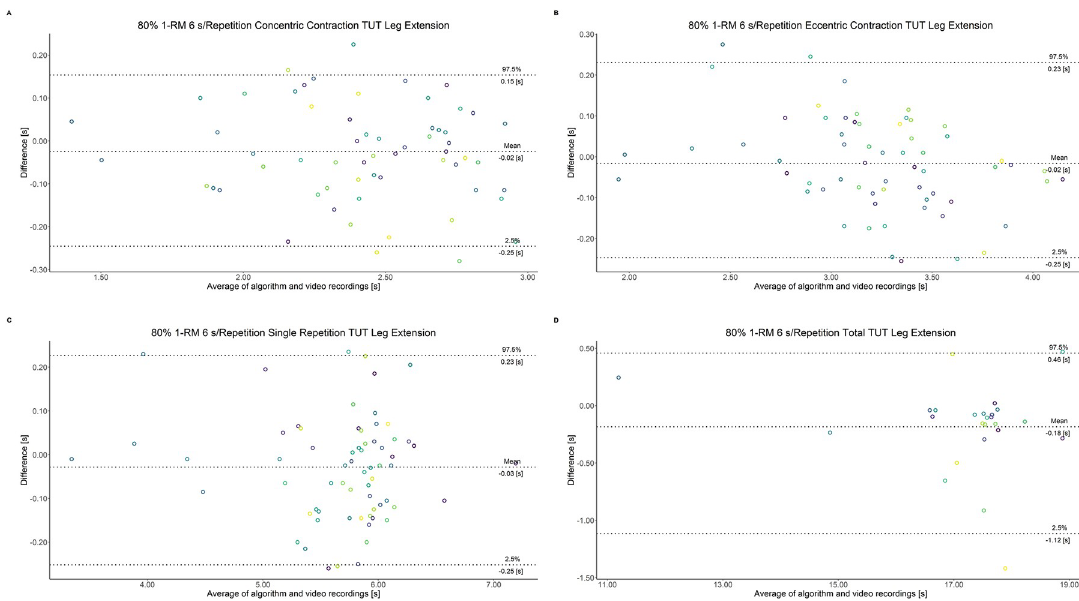
Fig 13. Bland-Altman plots of agreement between algorithmically accelerometer derived and video recordings derived contraction-specific phases of the leg extension machine at 80% 1-RM with a velocity of 6 s per repetition. A: Concentric contraction phase. B: Eccentric contraction phase. C: Single repetition. D: Total time-under-tension.